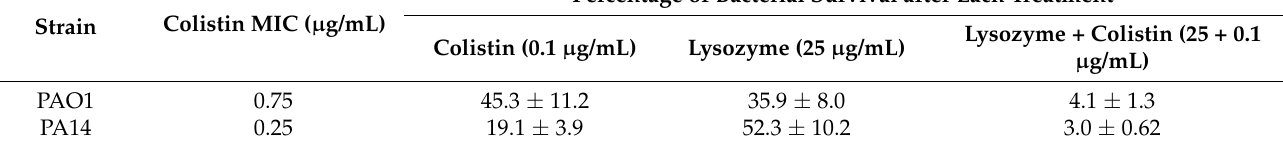
Table 2. Susceptibility to colistin and lysozyme, and the combined treatment (lysozyme + colistin) of two strains of Pseudomonas aeruginosa (PAO1 and